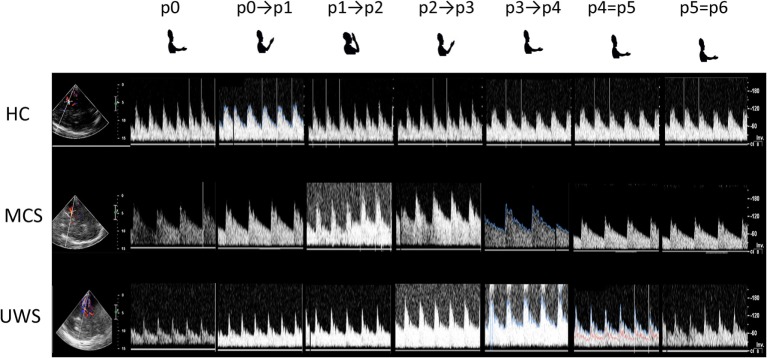
Shows the transcranial Doppler waveforms (on the right) with color Doppler (on the left) from left middle cerebral artery during passive mobilization across the six hand positions (p) explored in a representative subject for each group [healthy controls, minimally conscious state (MCS), and unresponsive wakefulness syndrome (UWS)]. Both insonation depth (left vertical bar) and flow velocity (centimeter per second, right vertical bar) are provided.